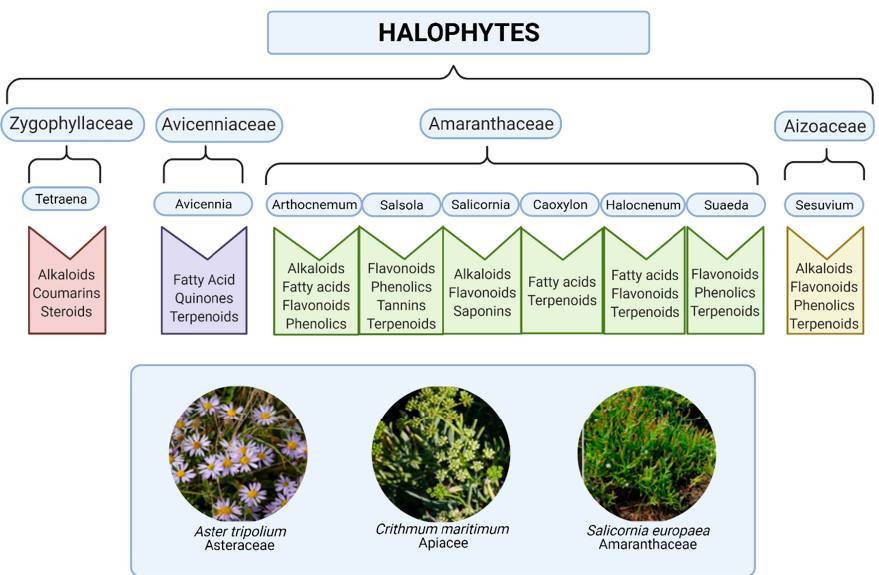
Figure 1. Phytochemical composition of some common coastal halophytes. Created with BioRen- der.com. (Pictures reproduced with permission [9])